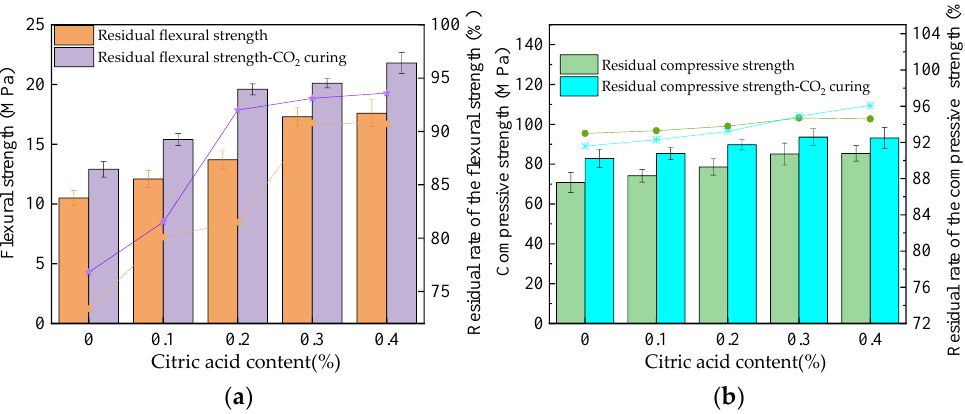
Figure 7. The residual strength of the MOS paste after water immersion. ( a ) Flexural strength. ( b ) Compressive strength.